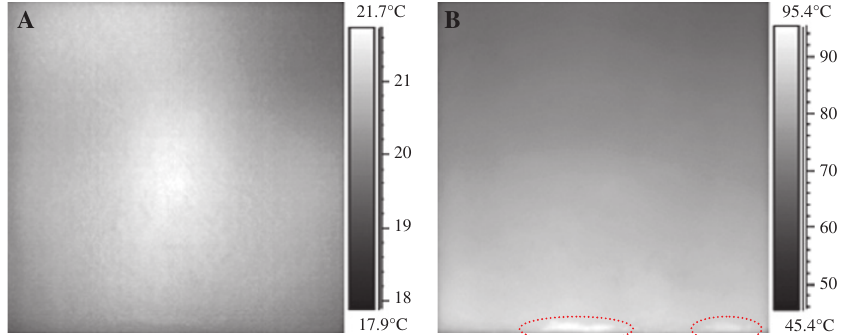
Figure 6 Raw thermograms: (A) at 1 s, (B) at 240